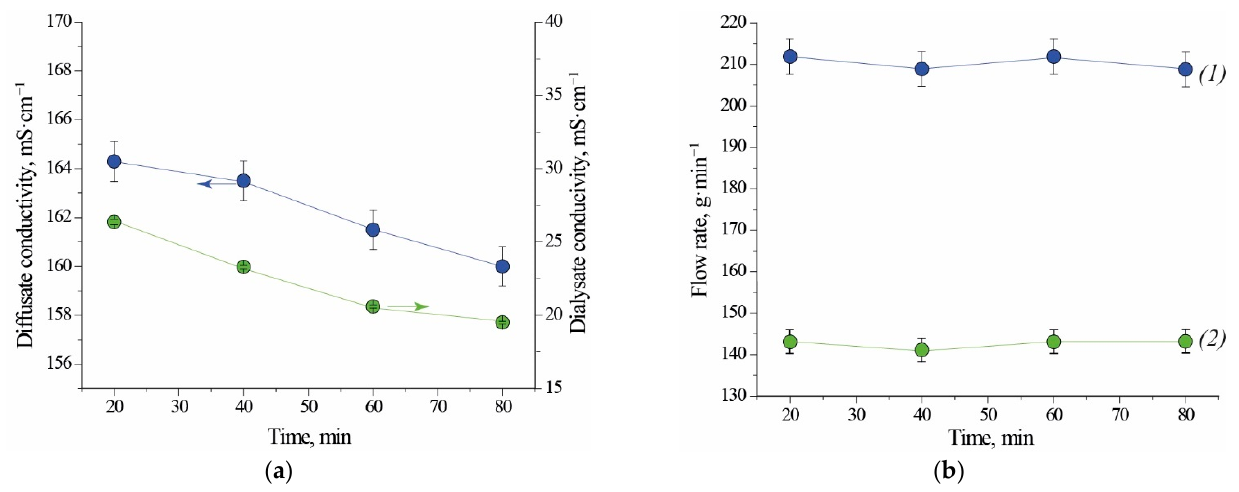
Figure 2. Conductivity ( a ) and flow rate ( b ) as a function of time for Test 2.1. (1) diffusate; (2) dialysate. Initial fill: DD profile from the previous testing. Note that the lines connecting experimental points are not true trendlines.